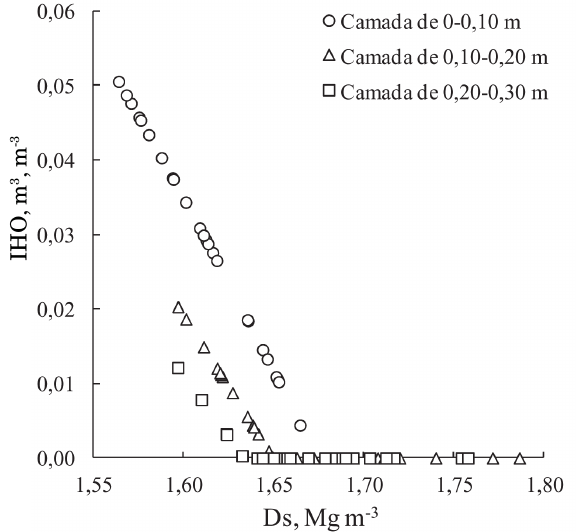
Figura 3. Intervalo hídrico ótimo (IHO) em função da Ds para as camadas de 0-0,10; 0,10-0,20; e 0,20-0,30 m do Latossolo Vermelho distrófico típico, em sistema de integração lavoura-